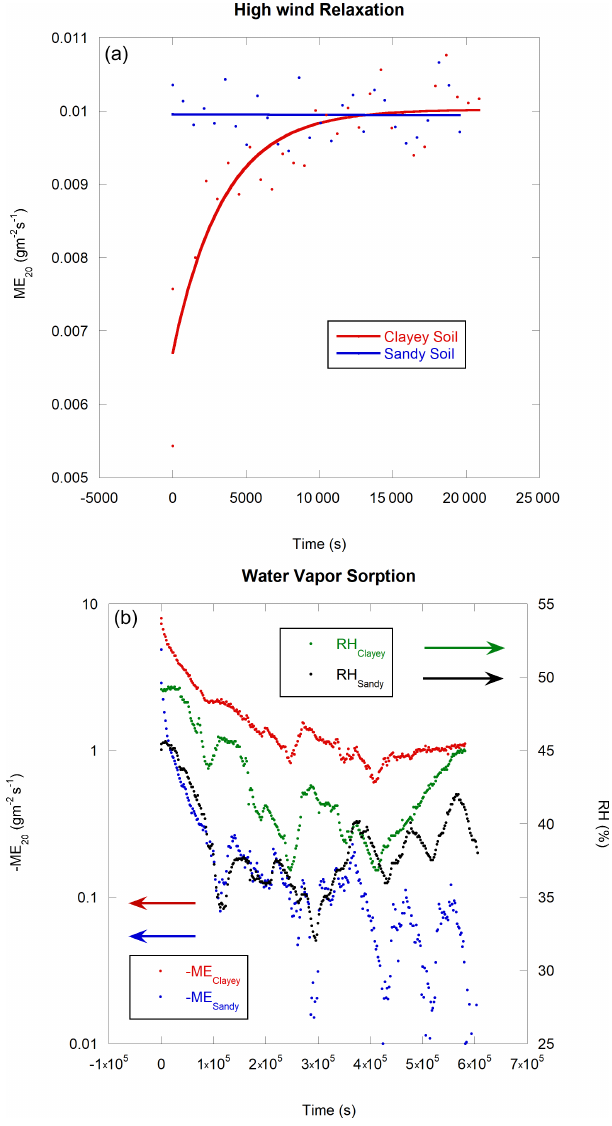
Figure 10. Measured (at PWM = 20%) evaporation ME versus time (a) after a strong wind ( W S = 2ms − 1 ) for clayey and sandy soil. The slide line represents a linear regression for sandy soil and an exponential rise regression for clayey soil. (b) After oven drying for 24h at 105 ◦